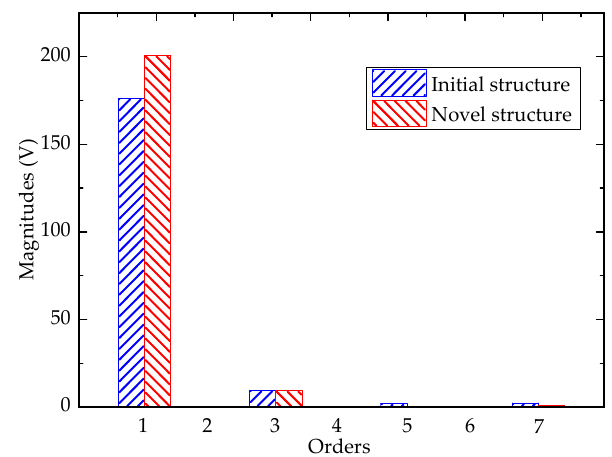
Figure 7. No ‐ load back ‐ EMFs of the two FSPM machines. Figure 7. No-load back-EMFs of the two FSPM machines. Energies 2020 , 13 , x FOR PEER REVIEW